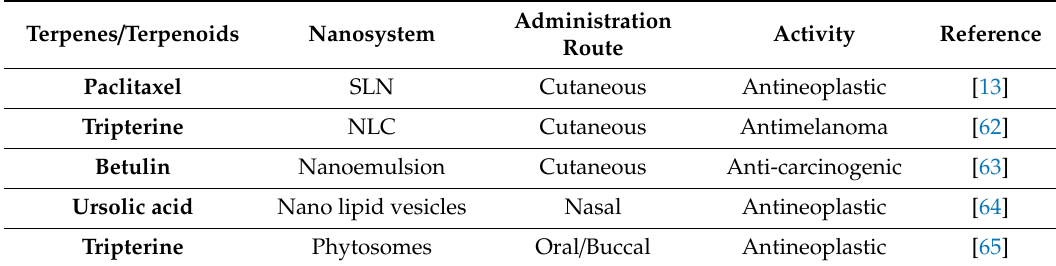
Table 3. Terpenes as anticancer bioactive compounds encapsulated in lipid based nanosystems.